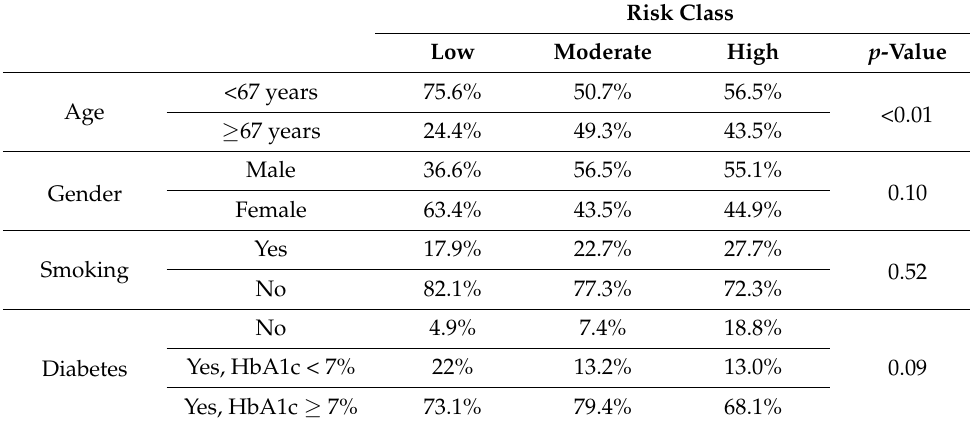
Table 8. Associations between demographic data and risk